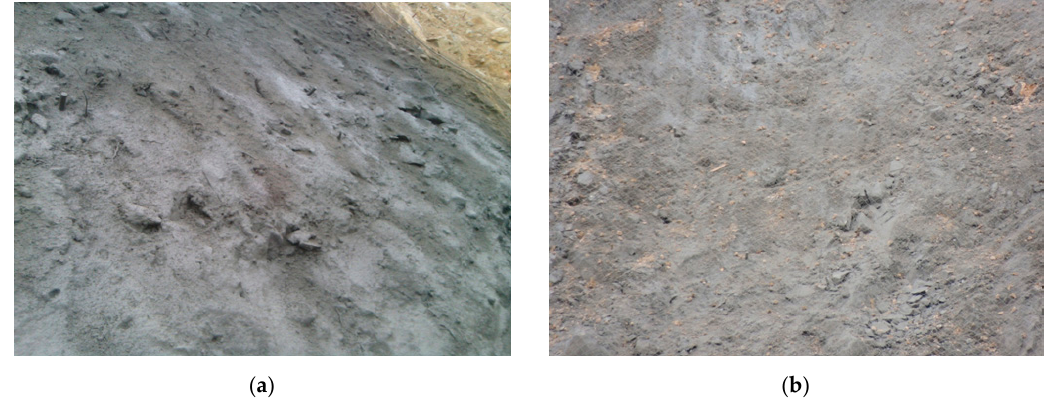
Figure 13. Curing effect: ( a ) Closed void; ( b ) loose particles of bonded surface. Figure 13. Curing e ff ect: ( a ) Closed void; ( b ) loose particles of bonded surface.